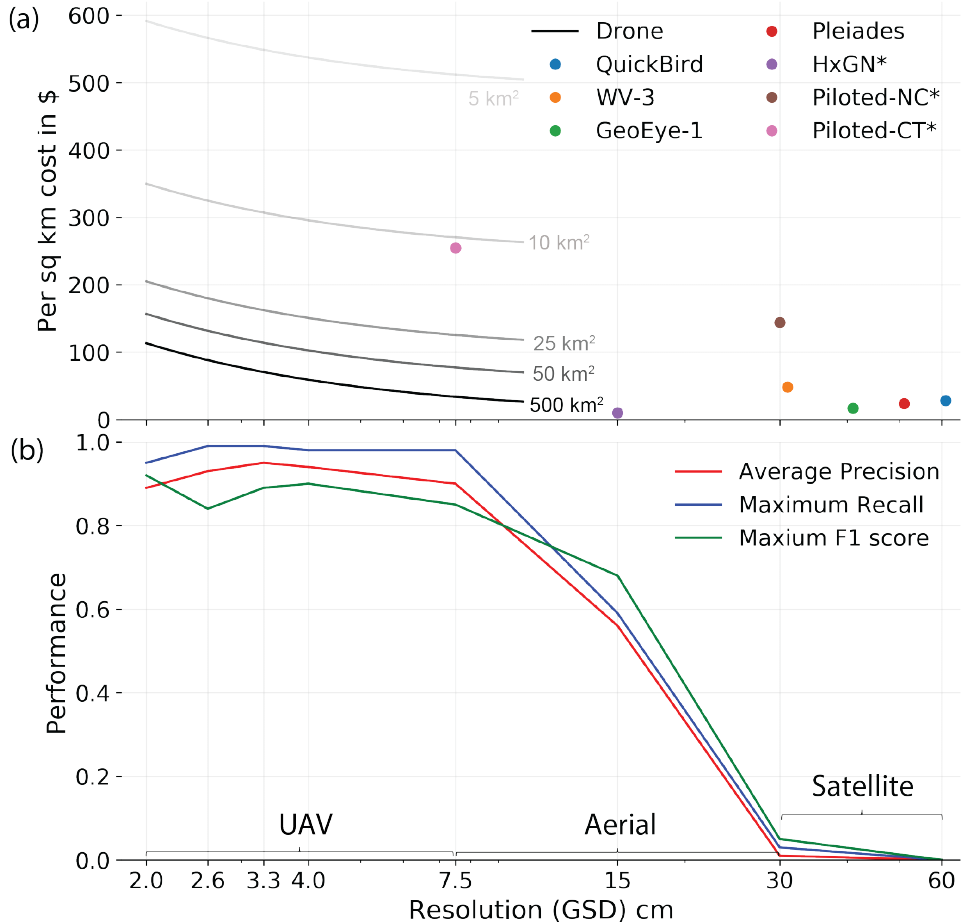
Figure 3. Cost and performance tradeoff with UAV and satellite imagery. ( a ) Cost per km 2 in USD versus resolution for UAV, satellite, and aerial imagery. Hexagon (HxGN*) provides archival piloted aerial imagery which is limited in coverage compared to satellite coverage. Pilot-{CT, NC}* are piloted new aerial imagery collection costs estimated from government documents of CT and NC USA. Note that unit costs vary with different target area sizes for drone operation. ( b ) Detection performance vs. resolution up to satellite resolutions with typical resolutions of platform